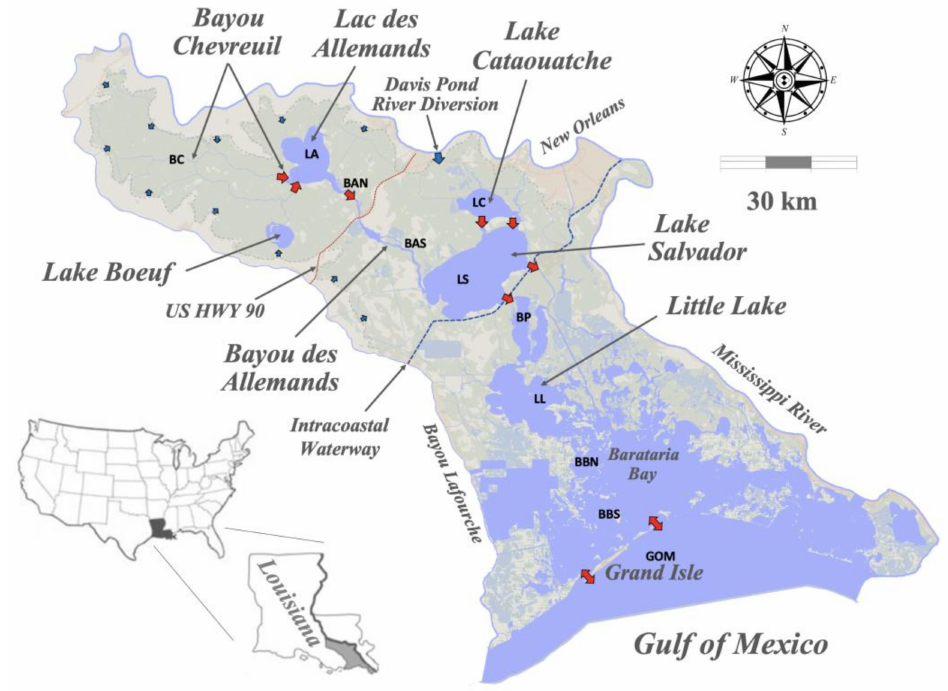
Figure 3. Map of the Barataria Basin (blue-water, green-wetlands, tan-uplands). Arrows indicate general hydrologic flow. Letters indicate station groupings used by [18] for water quality analysis of the basin: BC—Bayou Chevreuil, LA—Lac des Allemands, BAN—Bayou des Allemands north, BAS—Bayou des Allemands south, LS—Lake Salvador, LC—Lake Cataouatche, BP—Bayou Perot, LL—Little Lake, BBN—Barataria Basin north, BBS—Barataria Bay south, and GOM—Gulf of